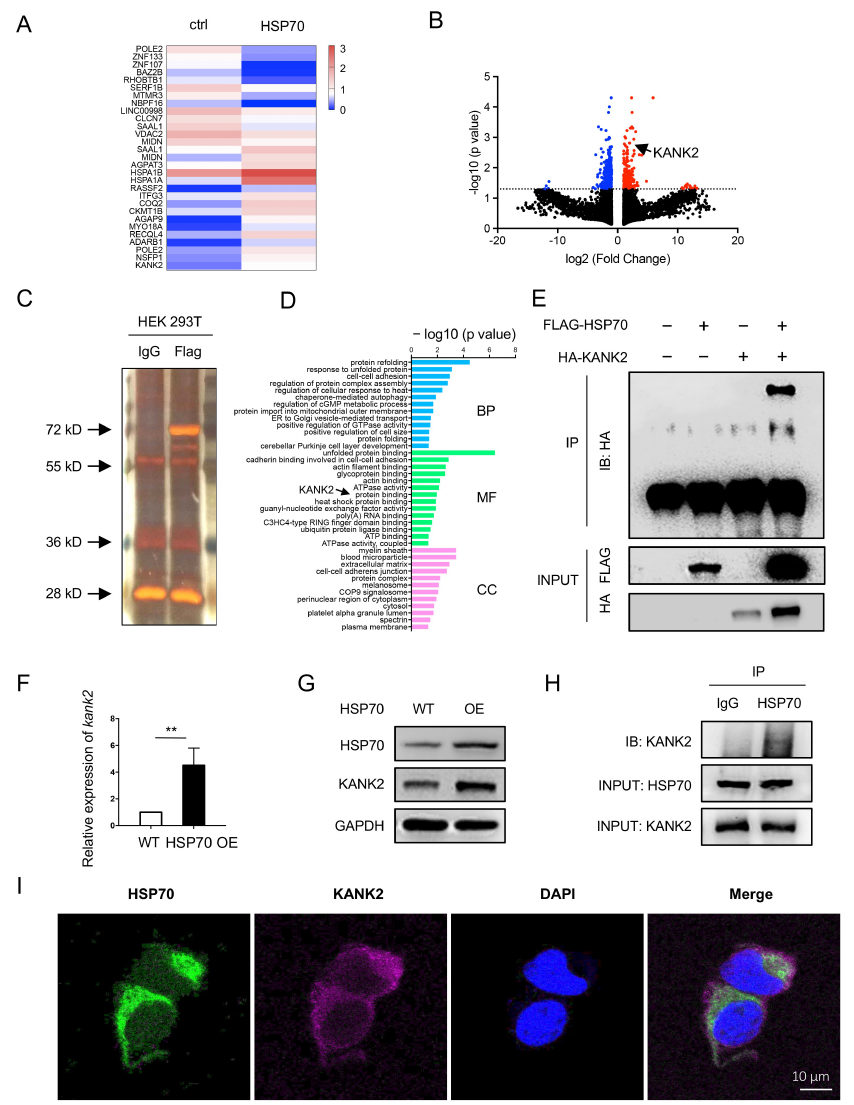
Figure 4. RNA sequencing and proteomics in HEK 293T cells and validation in A549 cells. HEK 293T cells were transfected with hsp70 -plasmid. Transcriptomes analysis was conducted in HEK 293T cells by RNA sequencing. Heat map of the cluster analysis ( A ) and volcano plot ( B ) was presented. The protein binding to HSP70 was extracted by IP (anti-Flag-HSP70). Then, the protein was separated by electrophoresis and stained with silver ( C ). Proteomics analysis was conducted by MS. Enrichment analysis for the binding protein was shown ( D ). IP was performed with an anti-Flag antibody. The expressions of HA-KANK2 and Flag-HSP70 were measured in HEK 293Ts. KANK2 bands were indicated with black arrow ( E ). A549 cells were cultured. The mRNA ( F ) and protein ( G ) levels of KANK2 in HSP OE A549 cells were measured using qPCR and WB. IP was performed with an anti- HSP70 antibody, and KANK2 was assessed in A549 cells ( H ). Representative immunofluorescence images of HSP70 and KANK2 in the A549 cells were acquired ( I ). Bar = 10 µ m. BP, biological process; CC, cellular component; MF, molecular function; MS, mass spectrometry. ** p <